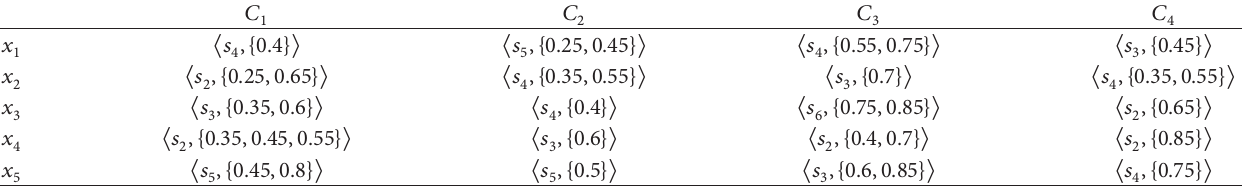
Table 1: The hesitant fuzzy linguistic decision